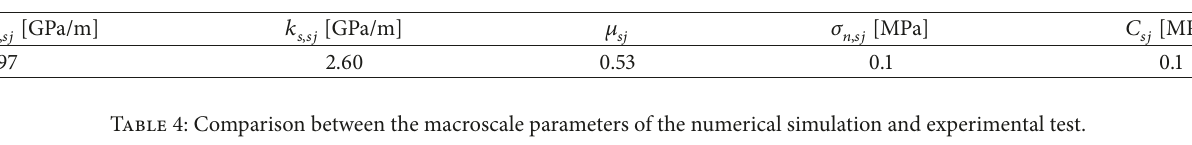
Table 3: Microscale parameters of the SJM after calibration.